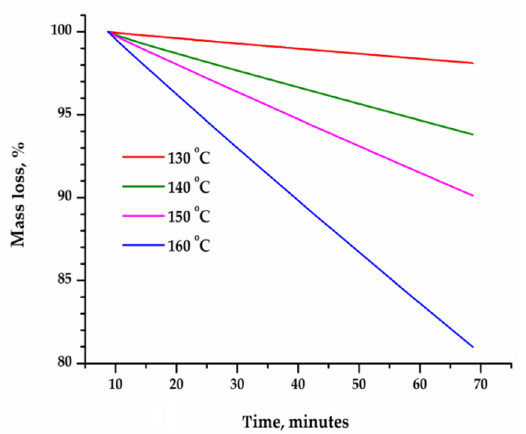
Figure 3. Percentage loss of mass over time for the sublimation of caffeine at various temperatures: 130, 140, 150 and 160 °C.